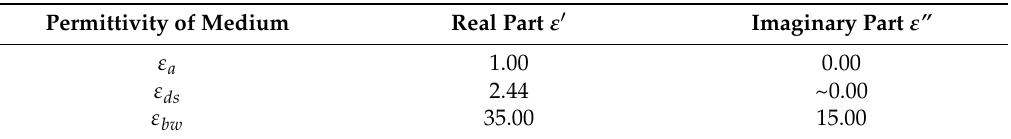
Table 1. Values for the real and imaginary part of the complex permittivity of air ε a , dry soil ε ds according to the soil properties of the observed soil and bound water ε bw [40].